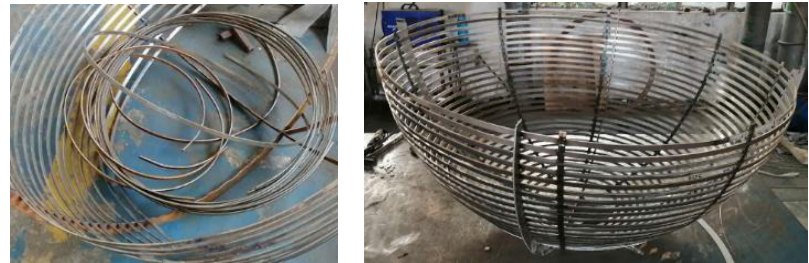
Figure 7. The manufactured hemispherical frame.